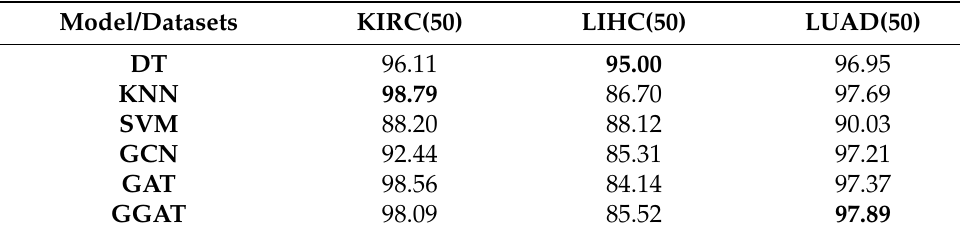
Table 9. Accuracy (%) of Models Under 50 Feature Dimensions.